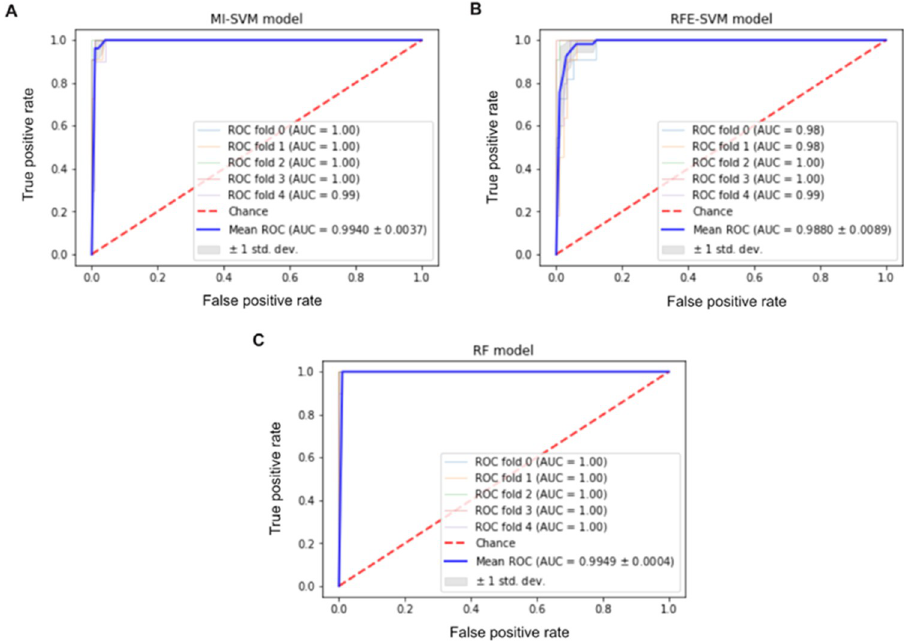
Fig 3. ROC and AUC analysis for different feature selection techniques. (A) MI-SVM model. (B) RFE-SVM model. (C) RF model.